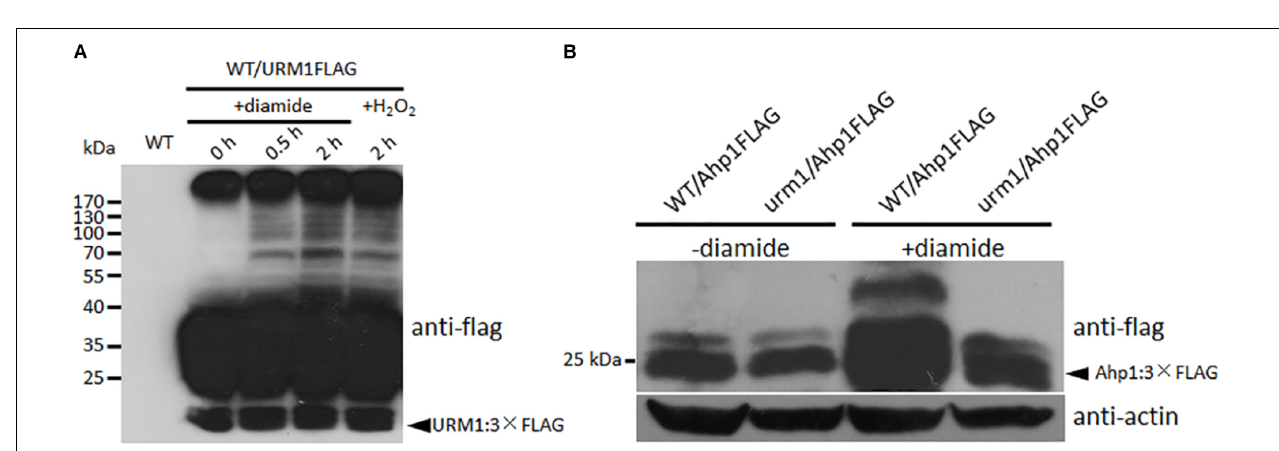
FIGURE 8 | Deletion mutant of URM1 is sensitive to H 2 O 2 , diamide and rapamycin. (A) The wild type, (cid:49) urm1 mutant and complemented strains were inoculated on CM plates supplemented with H 2 O 2 , diamide and rapamycin in indicated concentrations. The colonies were photographed at 5 dpi. (B) Statistical analysis of inhibition rate based on colony diameters. Means and standard errors were calculated from three independent replicates. Significant differences are indicated by asterisks ( P < 0.05).